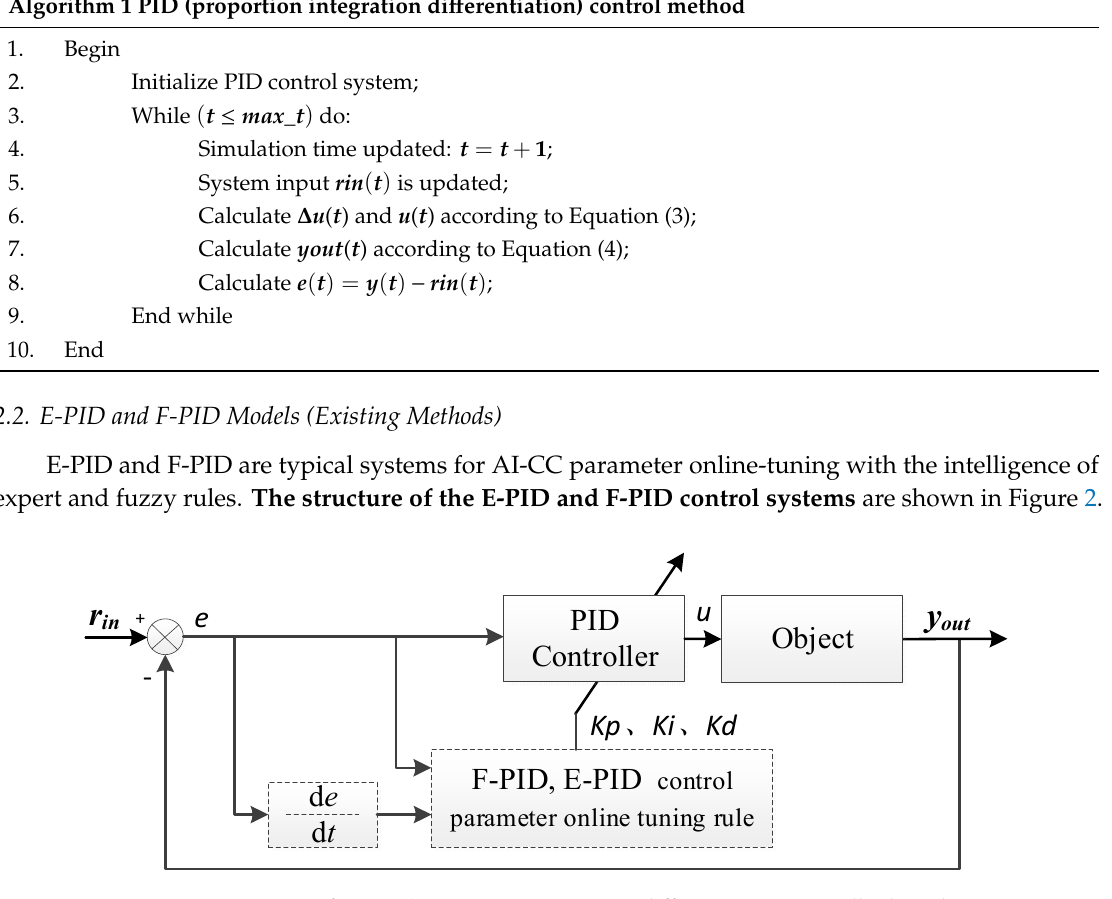
Figure 2. System structure of E-PID (proportion integration differentiation controller based on expert system)and F-PID (proportion integration differentiation controller based on fuzzy calculation)systems.